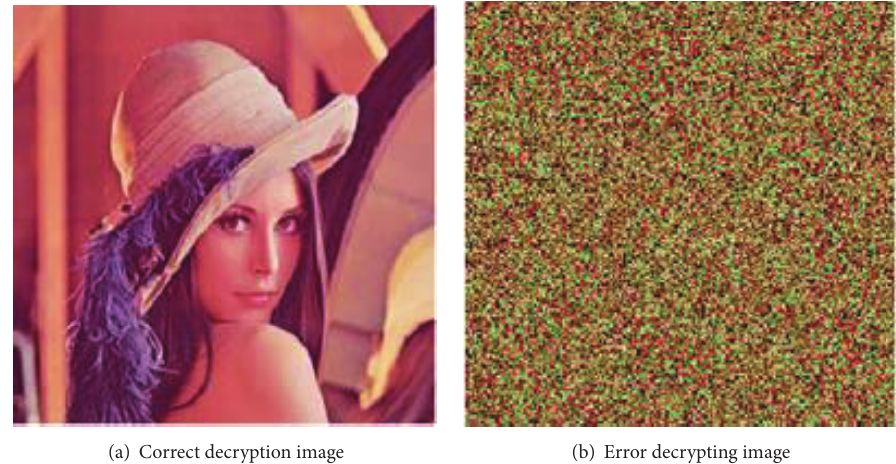
Figure 10: Key sensitivity testing.